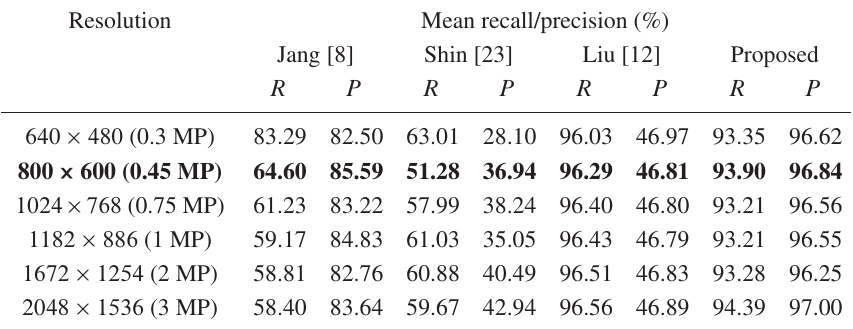
Table 2. Comparison of different binarization techniques with the proposed one for various